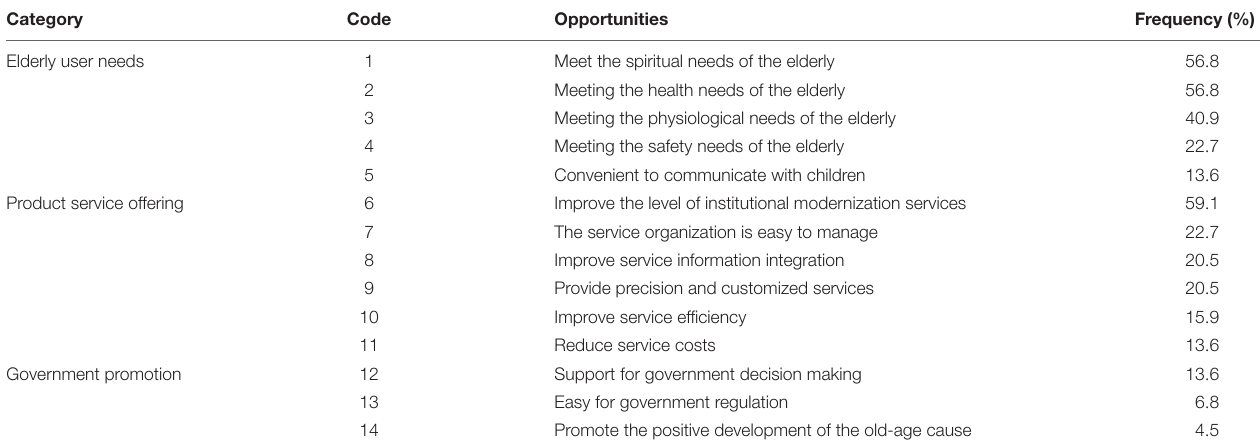
TABLE 4 | Opportunities for Chinese elderly care industry in the smart